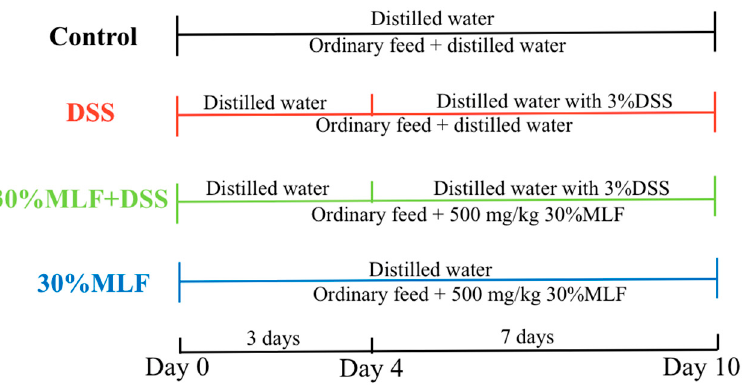
Figure 11. Experimental design of DSS-induced colitis in mice.